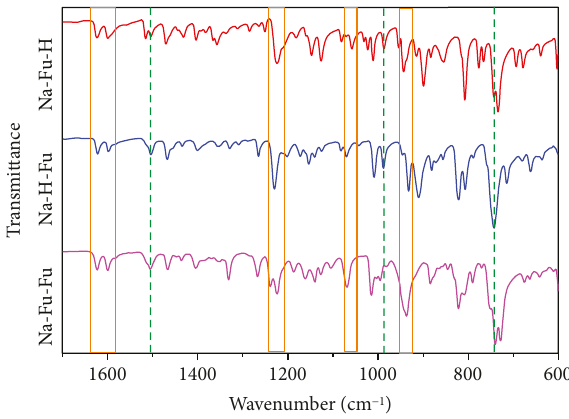
Figure 3: FTIR spectra of the naphthoxazines containing furan groups.